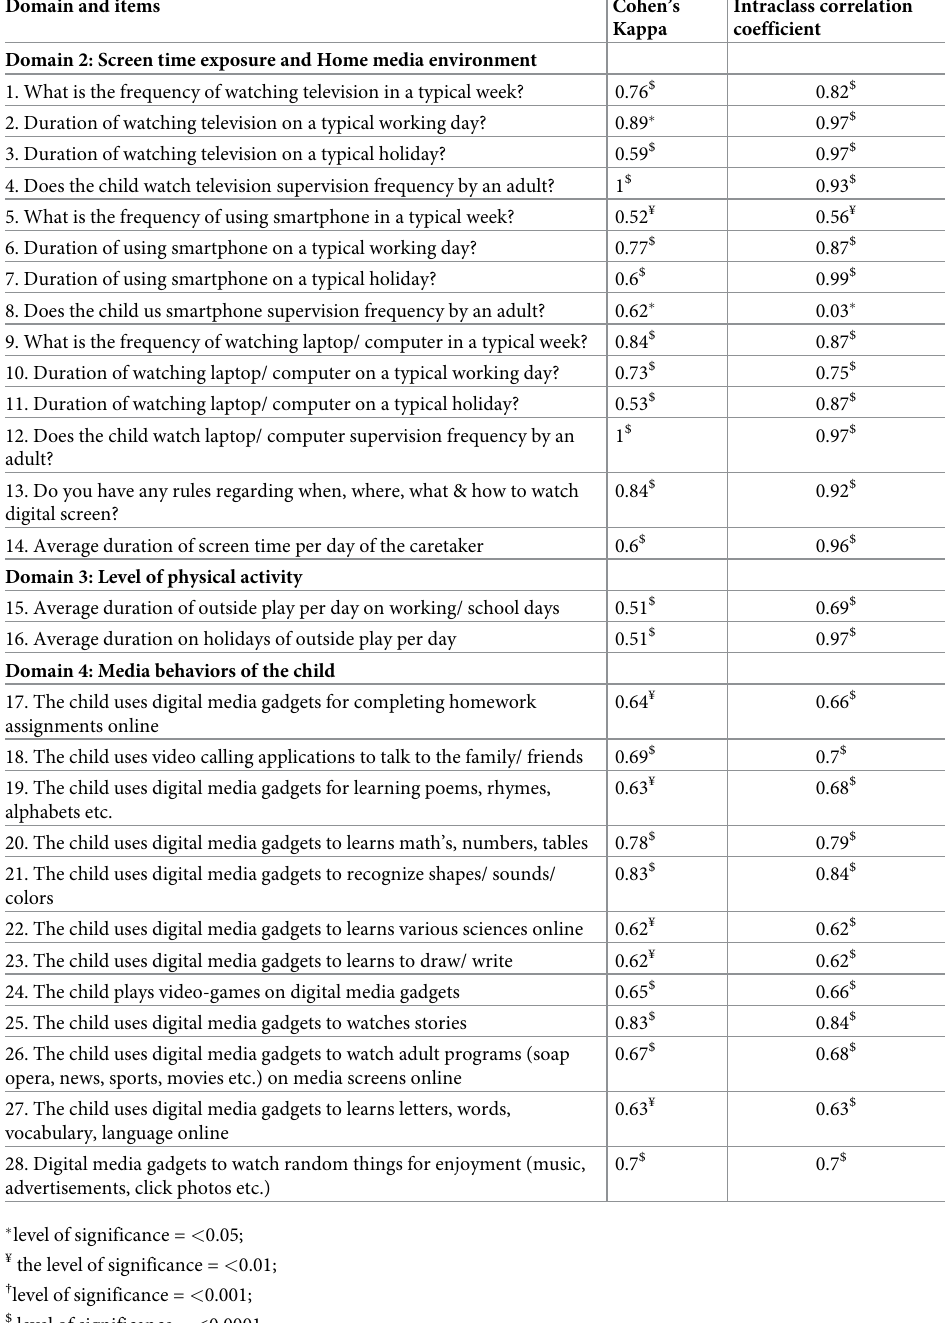
Table 3. Internal consistency and reliability of questions measuring duration, frequency, patterns, and content of screen-time usage among